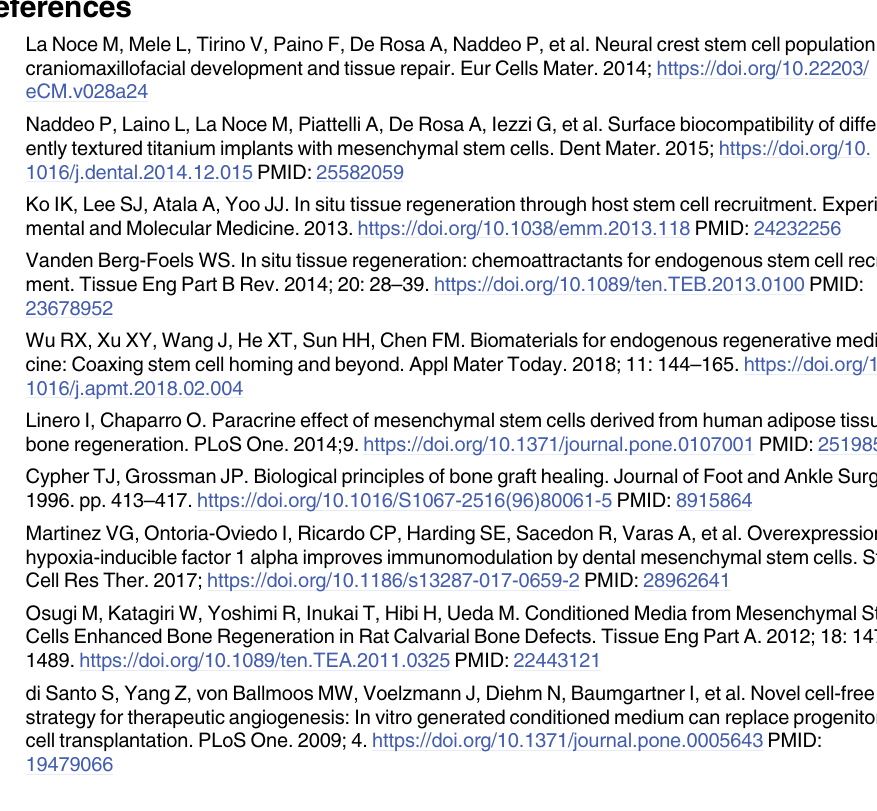
S1 Table. Primer sequences for qPCR